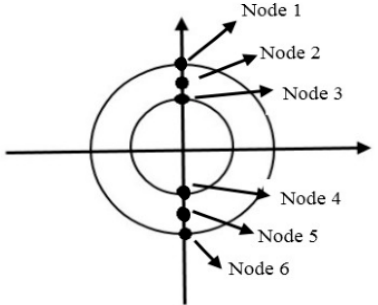
Figure 8. Sketch of the nodes at the monitoring plane.